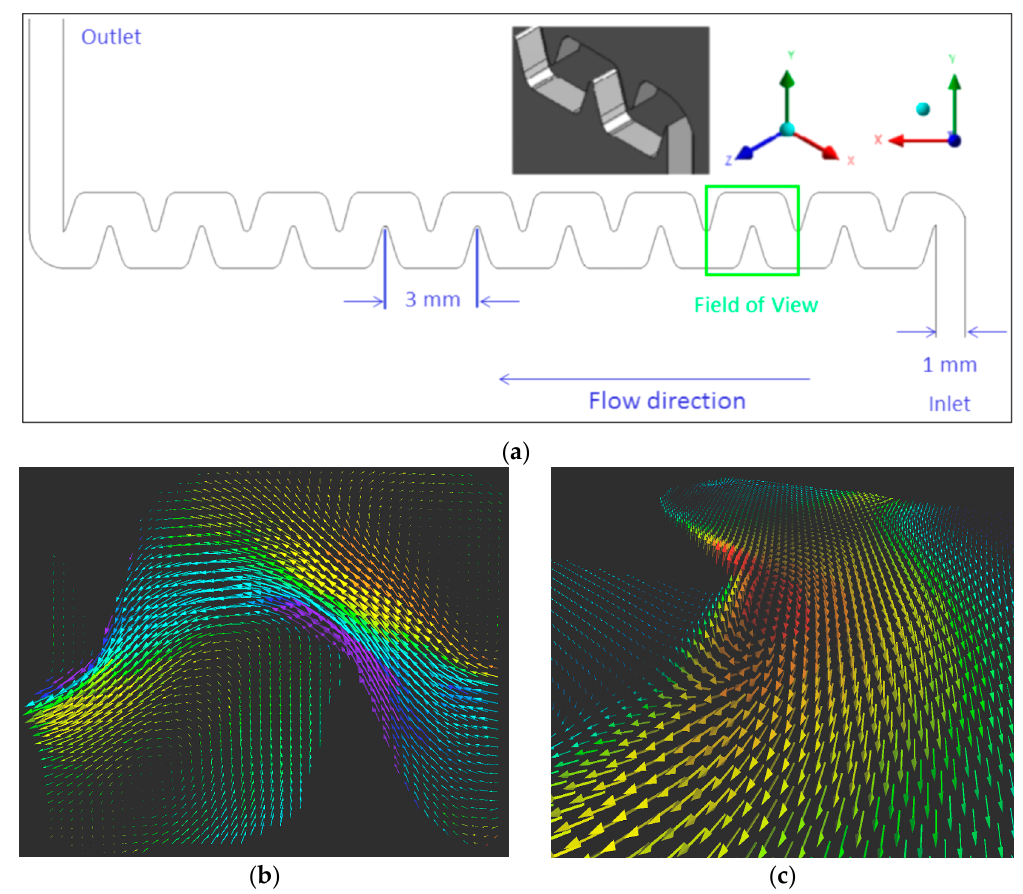
Figure 10. ( a ) Serpentine-micromixer schematic and its dimensions in mm. ( b ) 2D view of the mean velocity field. Average of 910 velocity fields in a FoV of 3.0 mm × 3.0 mm. Colors indicate the out-of-plane velocity component ( w < ± 0.3 m/s). ( c ) 3D view of the mean velocity field (as in Figure 10b) showing a large vortex observed originating from one of the sharp corners of the serpentine micromixer. Colors indicate the magnitude of the velocity vector (0 < V < 1 m/s). Re = 400.